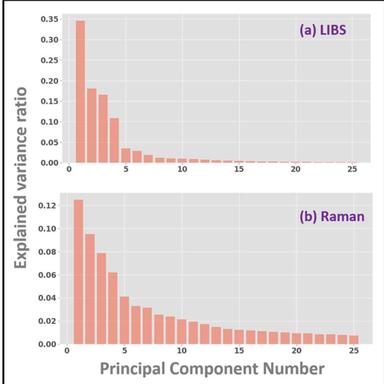
Explained variance ratio vs. Principal Component Number plot for PCA decomposition of spectral data from plastics (a) LIBS data and (b) Raman data.